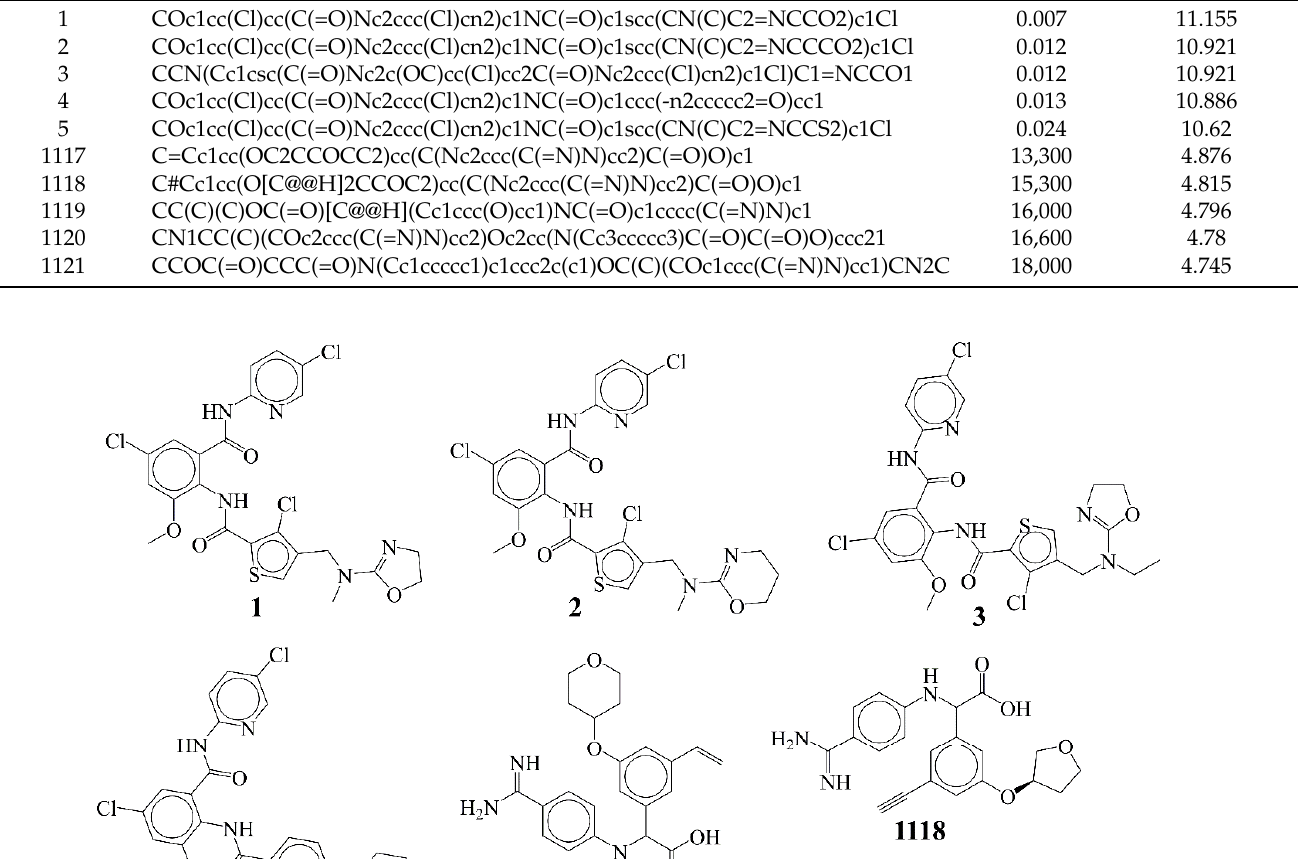
Table 1. SMILES notation, Ki (nM) and pKi (M) of five most and least active molecules of the selected data set. S.N.